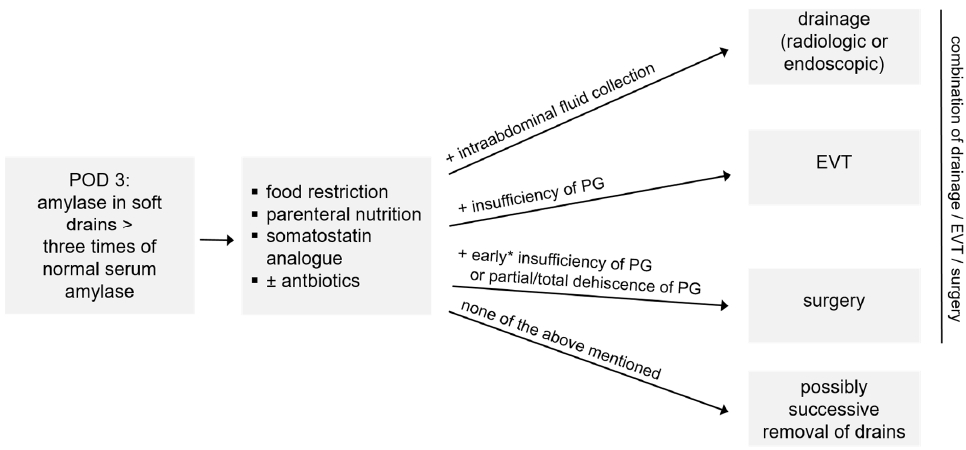
Figure 2. Management of POPF °B/C: how we do it. * within the first 3 days after surgery; EVT = endoscopic vacuum-assisted closure therapy, PG = pancreatogastrostomy, POD = postoperative day.